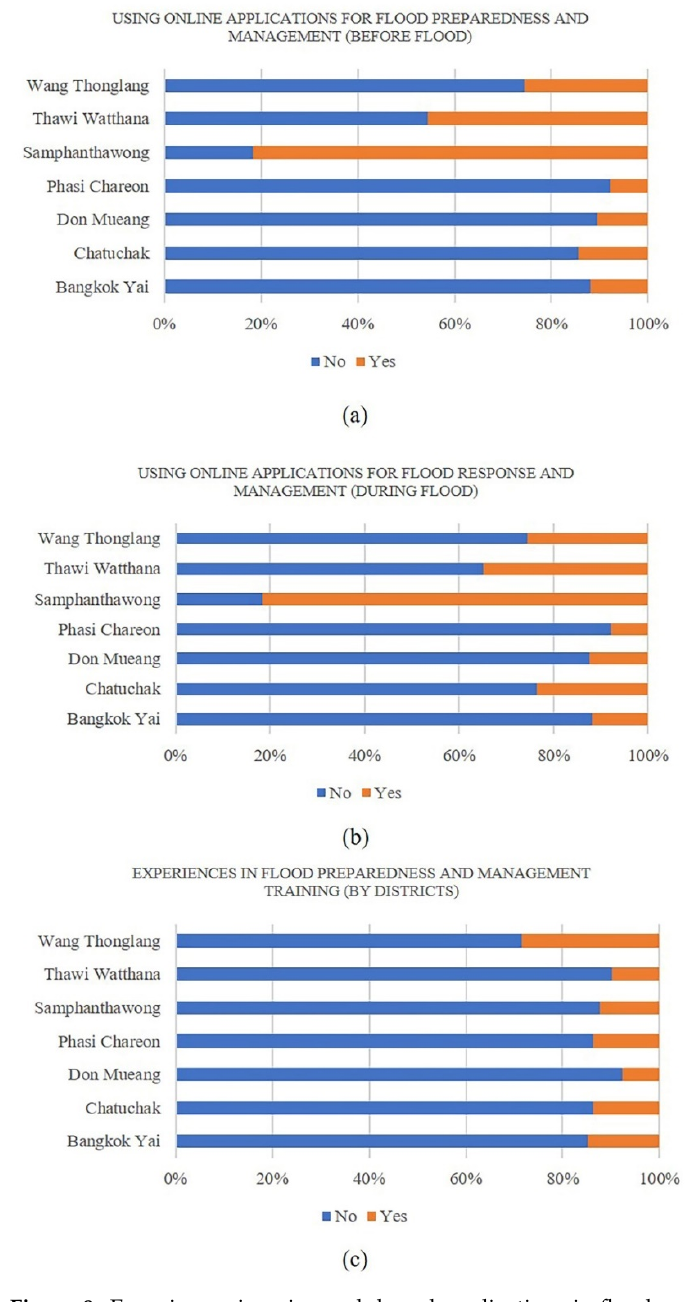
Figure 8. Experiences in using web-based applications in flood management both ( a ) before and ( b ) during flood disaster, and ( c ) flood training experiences (by districts) (n = 736).